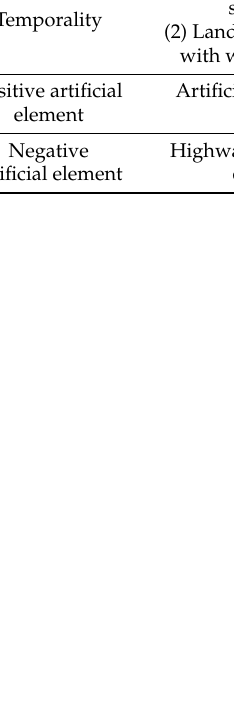
Table 3. Classification standard of habitat units in urban wetland parks